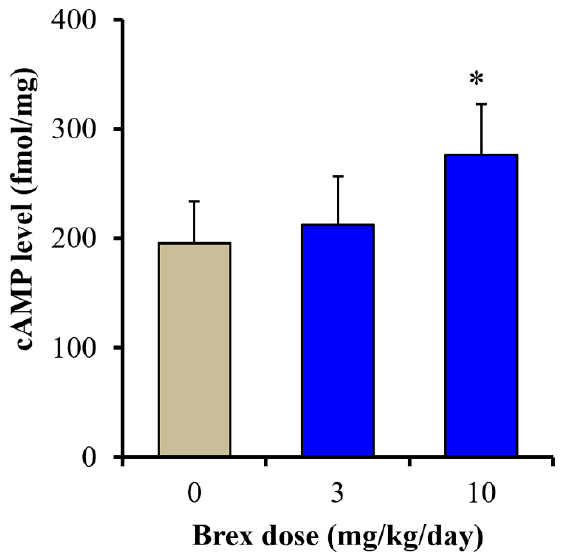
Figure 9. Effects of subchronically systemic administration (14 days) of effective doses of Brex (3 and 10 mg/kg/day) on cAMP levels in the rat hypothalamus. Ordinates indicate mean ± SD ( n = 6) of cAMP level in the rat hypothalamus (fmol/mg). * p < 0.05: relative to control (Brex-free) by one-way ANOVA with Tukey’s post-hoc